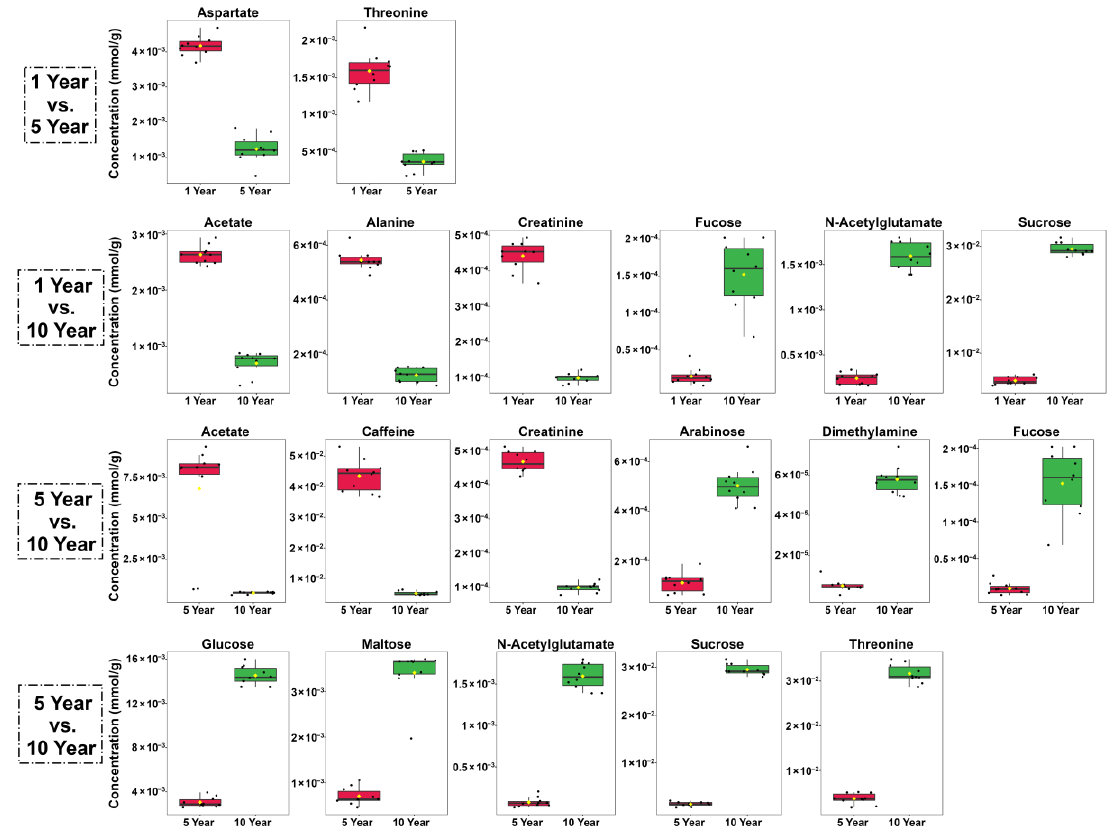
Figure 4. Boxplot based on the concentration of molecules whose fold change is above 2 in each of the two groups. Asterix indicates the mean value of the group in each box.